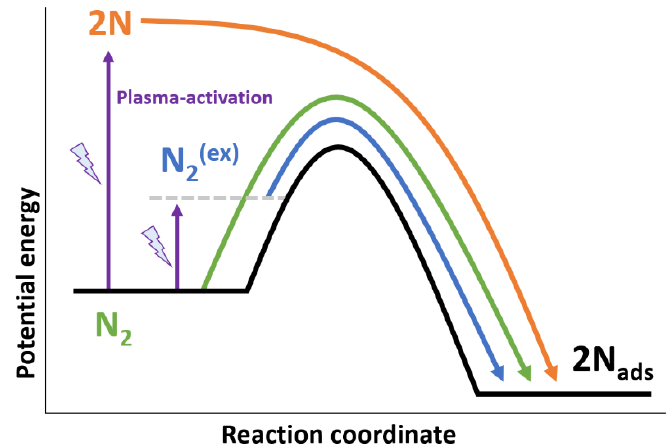
Figure 4. Various mechanisms for N 2 activation by the plasma and subsequent dissociative adsorption on a metal surface. Green: thermal N 2 activation on a catalyst. Blue: plasma-activated molecular N 2 dissociating over the metal with a barrier over the catalyst. Orange: complete dissociation of N 2 by the plasma, followed by barrierless adsorption on the metal surface.